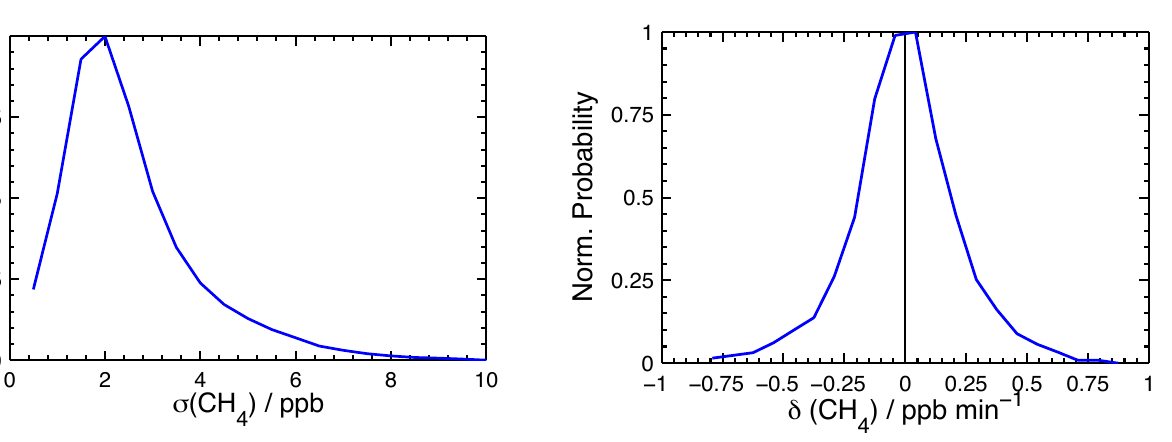
Fig. 9. PDF of the airborne accuracy expressed as deviation of the individual airborne calibration measurements from the linear cali- bration function for each flight. On average the accuracy is found to be ∆ CH 4 ∼ 3 . 4 ppb ( 1 σ ) at the aircraft cruising altitude.